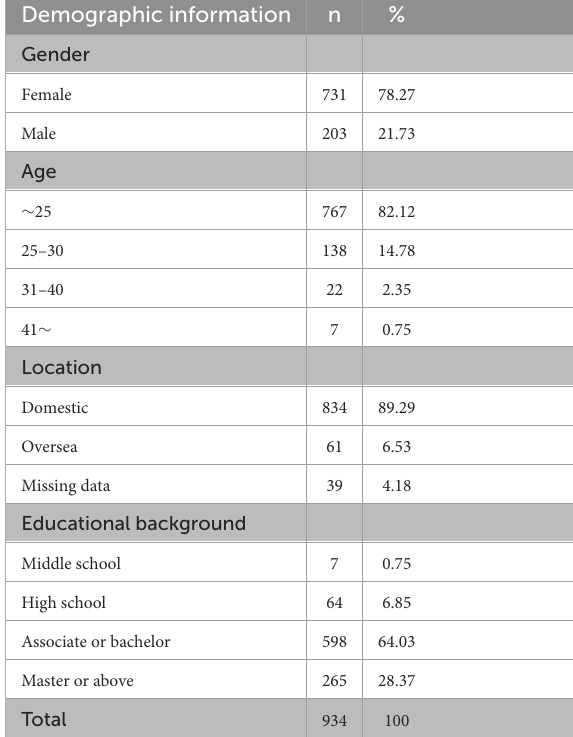
TABLE 2 Demographic information of